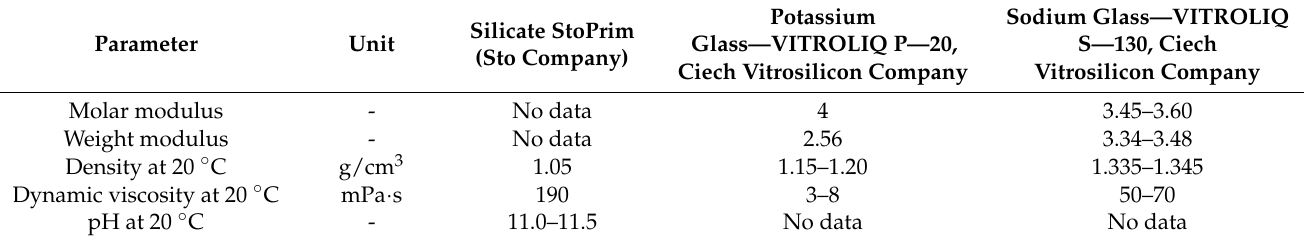
Table 3. The most important data of the substances used in the production of gypsum